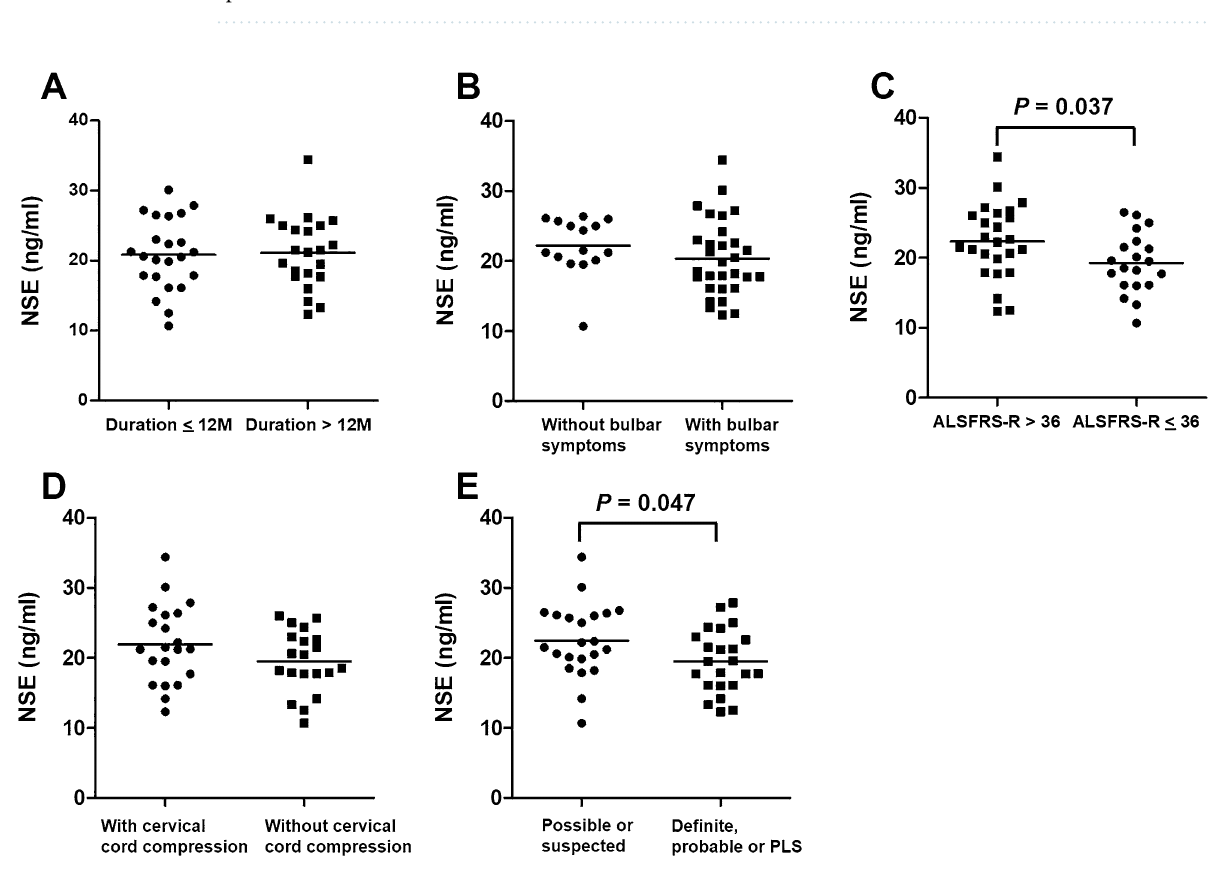
Figure 3. Receiver operating characteristic curves for distinguishing ALS from CSM based on CSF NSE levels. ALS amyotrophic lateral sclerosis, CSF cerebrospinal fluid, CSM cervical spondylotic myelopathy, NSE neuron- specific enolase.